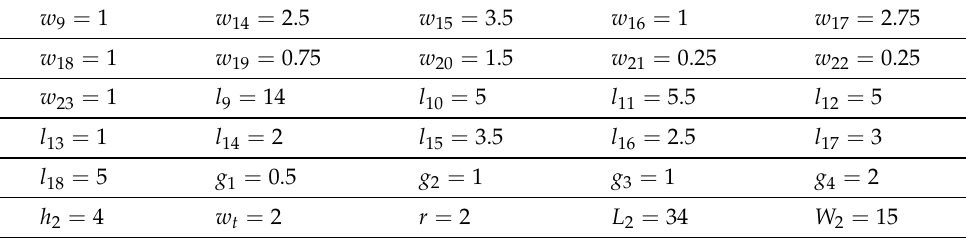
Table 2. Design parameters of the wideband antenna (Ant#3). All dimensions are in millimeters. w 9 = 1 w 14 =